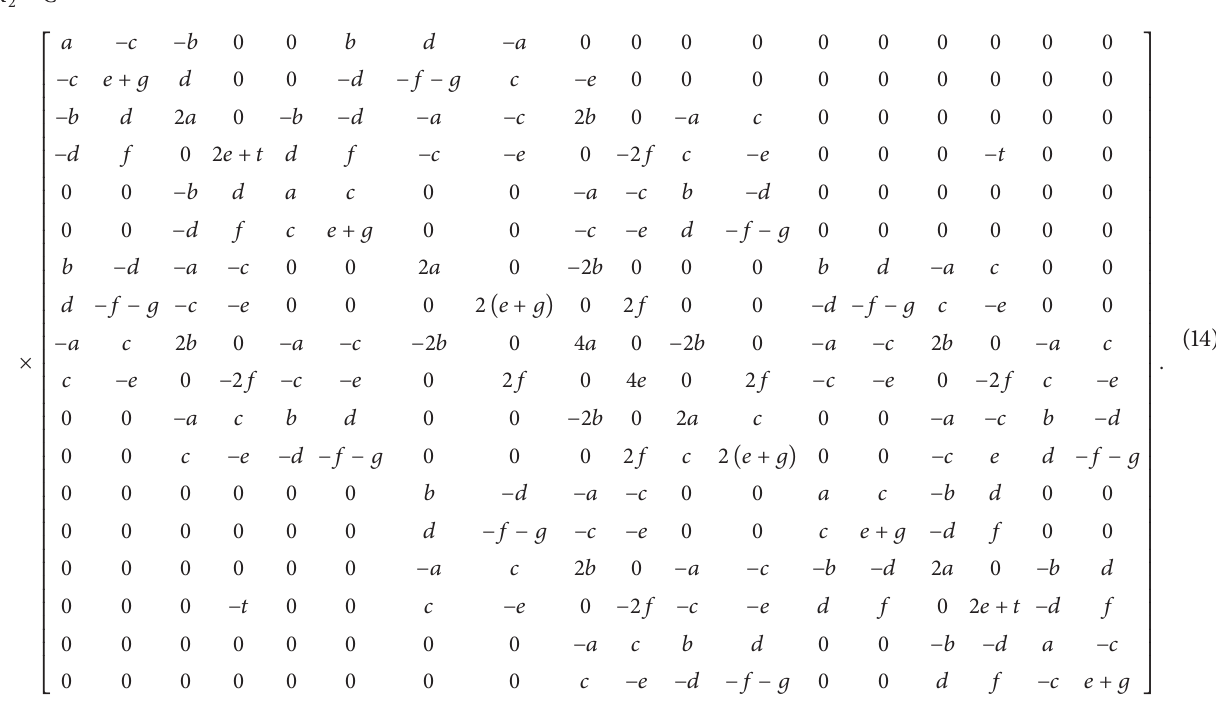
FE model results in plane stress and plane strain